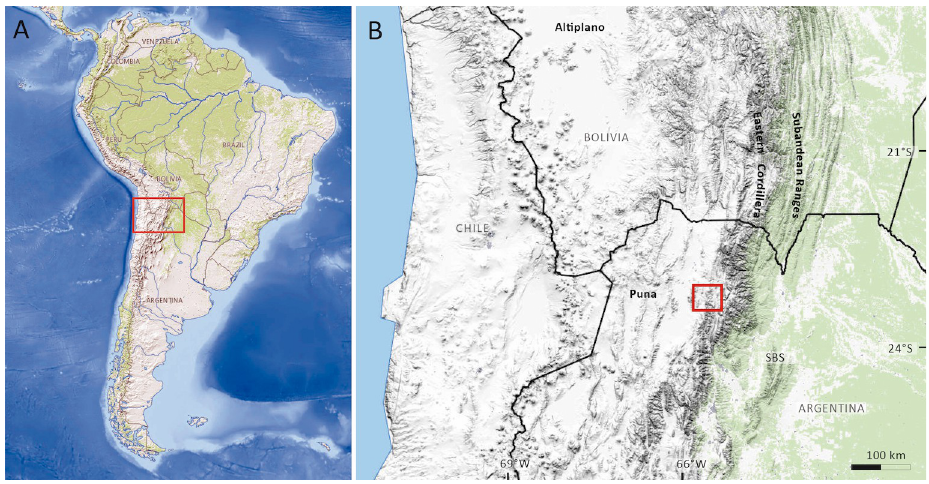
Fig 1. Location map. (A) Map of South America indicating the region covered by the present study. (B) Map of northern Chile, southern Bolivia and northwestern Argentina, indicating the sample site (Casa Grande Fm, Jujuy Province). Maps were taken from USGS National Map Viewer (public domain).